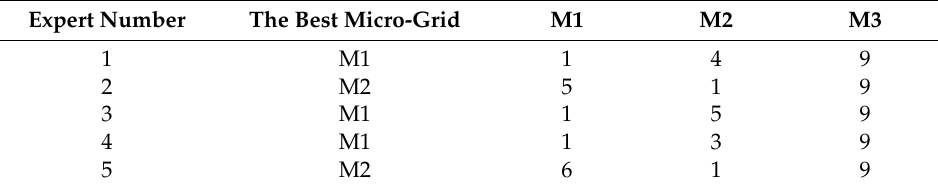
Table 4. Compared results of the best micro-grid planning program over others.